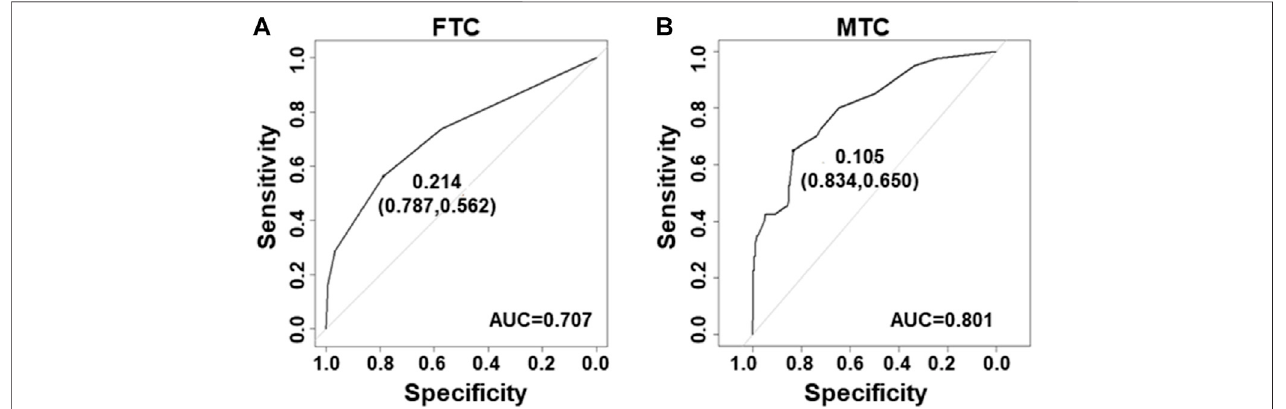
FIGURE 3 | Receiver – operating characteristic curves for the prediction model in FTC and MTC. (A) Curve of the model derived from FTC data (AUC (cid:1) 0.707). (B) Curve of the model from MTC data (AUC (cid:1) 0.801).